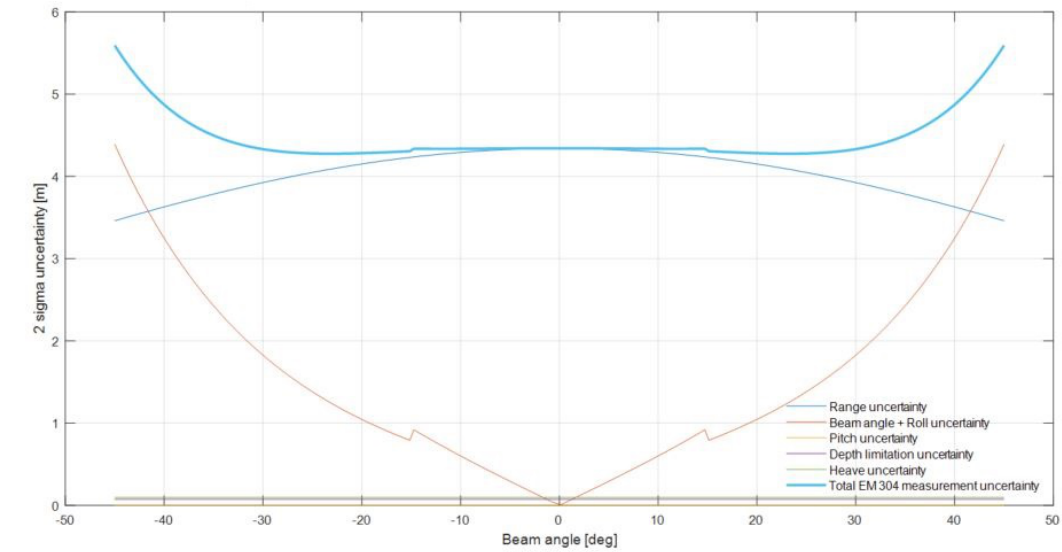
Figure 17. Uncertainties related to the EM 304 multibeam echosounder at the depth of 1000 m, for the swath width of 2000 m.